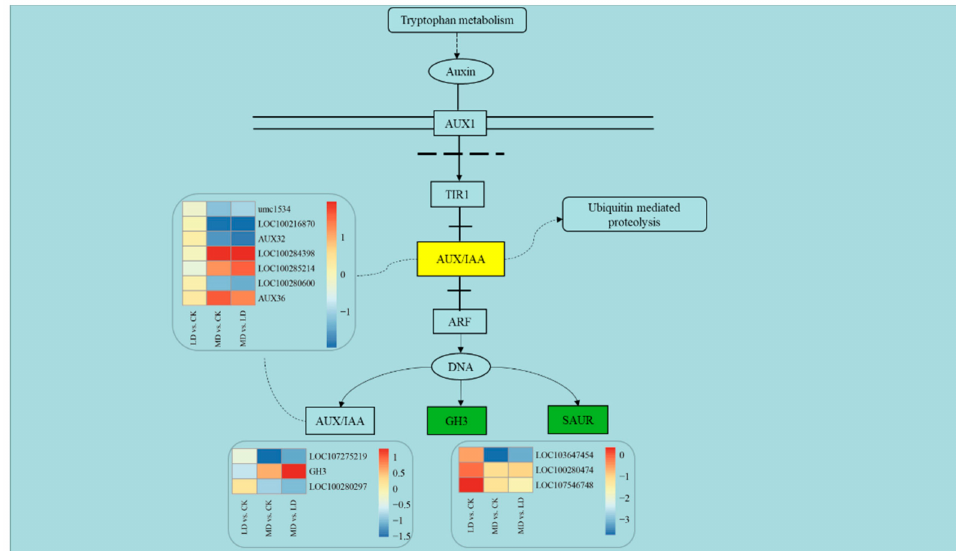
Figure 7. Genes involved in auxin plant hormone signal transduction pathway in the Kyoto Encyclopedia of Genes and Genomes (KEGG). Di ff erentially expressed genes involved in AUX / IAA, GH3, and SAUR were shown by heat-maps, and the number was calculated with log2foldchange in three comparisons. Color of heat-maps represented di ff erent fold change. Yellow box means involved significantly di ff erentially expressed genes were mainly up-regulated, and green box means down-regulated.